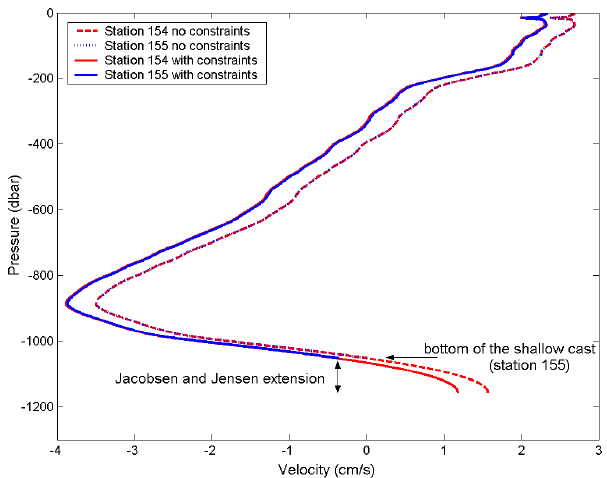
Fig. 6 Fig. 6. Velocity profiles with (solid lines) and with no (dashed lines) constraints applied for two station halves between stations 154 and 155 in 2004 located on the Svalbard slope in the 79 ◦ N section (lo- cations shown in Fig. 3). Velocity is first set to zero at the bottom of the shallow cast and method of Jacobsen and Jensen is used to estimate the velocity below this level for the deep